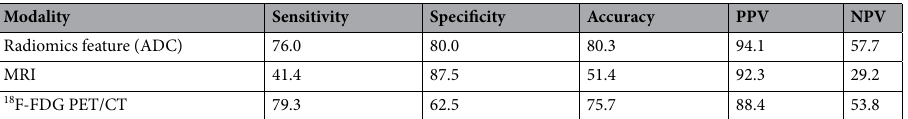
Table 4. Diagnostic performance to detect occult palatine tonsil SCC using different imaging modalities. Numbers for diagnostic performance are percentages. ADC apparent diffusion coefficient; PPV positive predictive value; NPV negative predictive